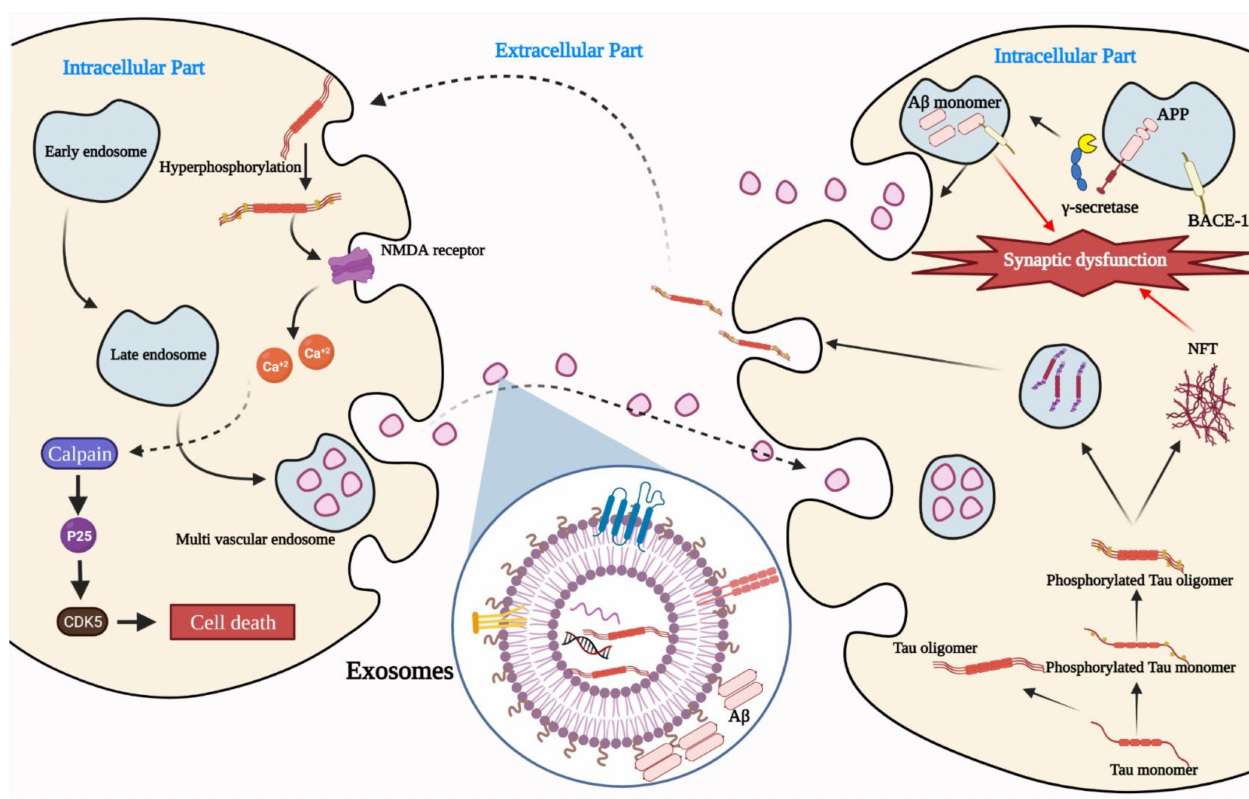
Figure 1. The pathological role of exosomes in AD. NMDA: N-methyl-D-aspartate receptor, CDK5: cyclin-dependent kinase 5, P25: protein 25, A β : amyloid-beta, APP: amyloid precursor protein, NFT: neurofibrillary tangles, BACE-1: beta-site amyloid precursor protein cleaving enzyme 1. 636 × 408 mm (118 × 118